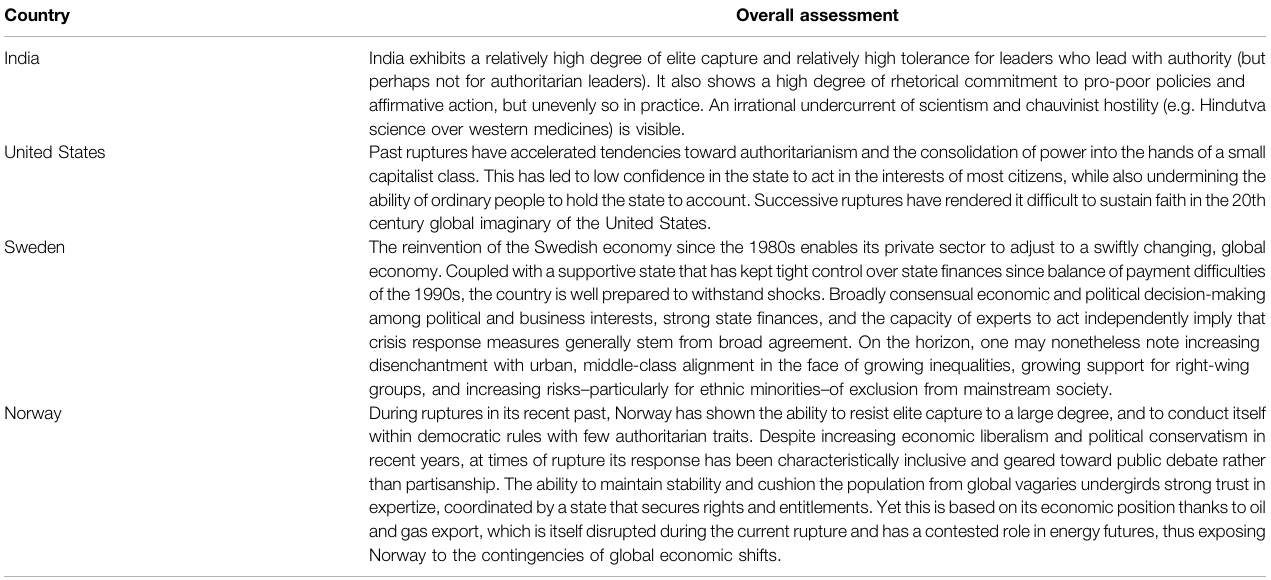
TABLE 3 | Overall assessment of state characteristics for the four country cases. Country Overall assessment